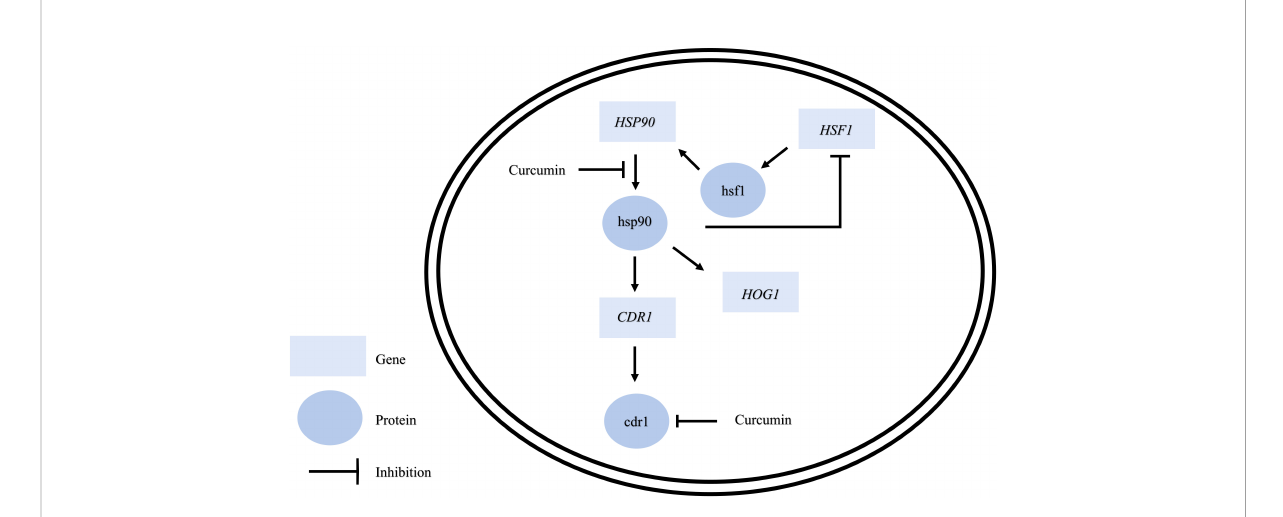
FIGURE 11 Model for the mechanism of curcumin ’ s effects on C. albicans